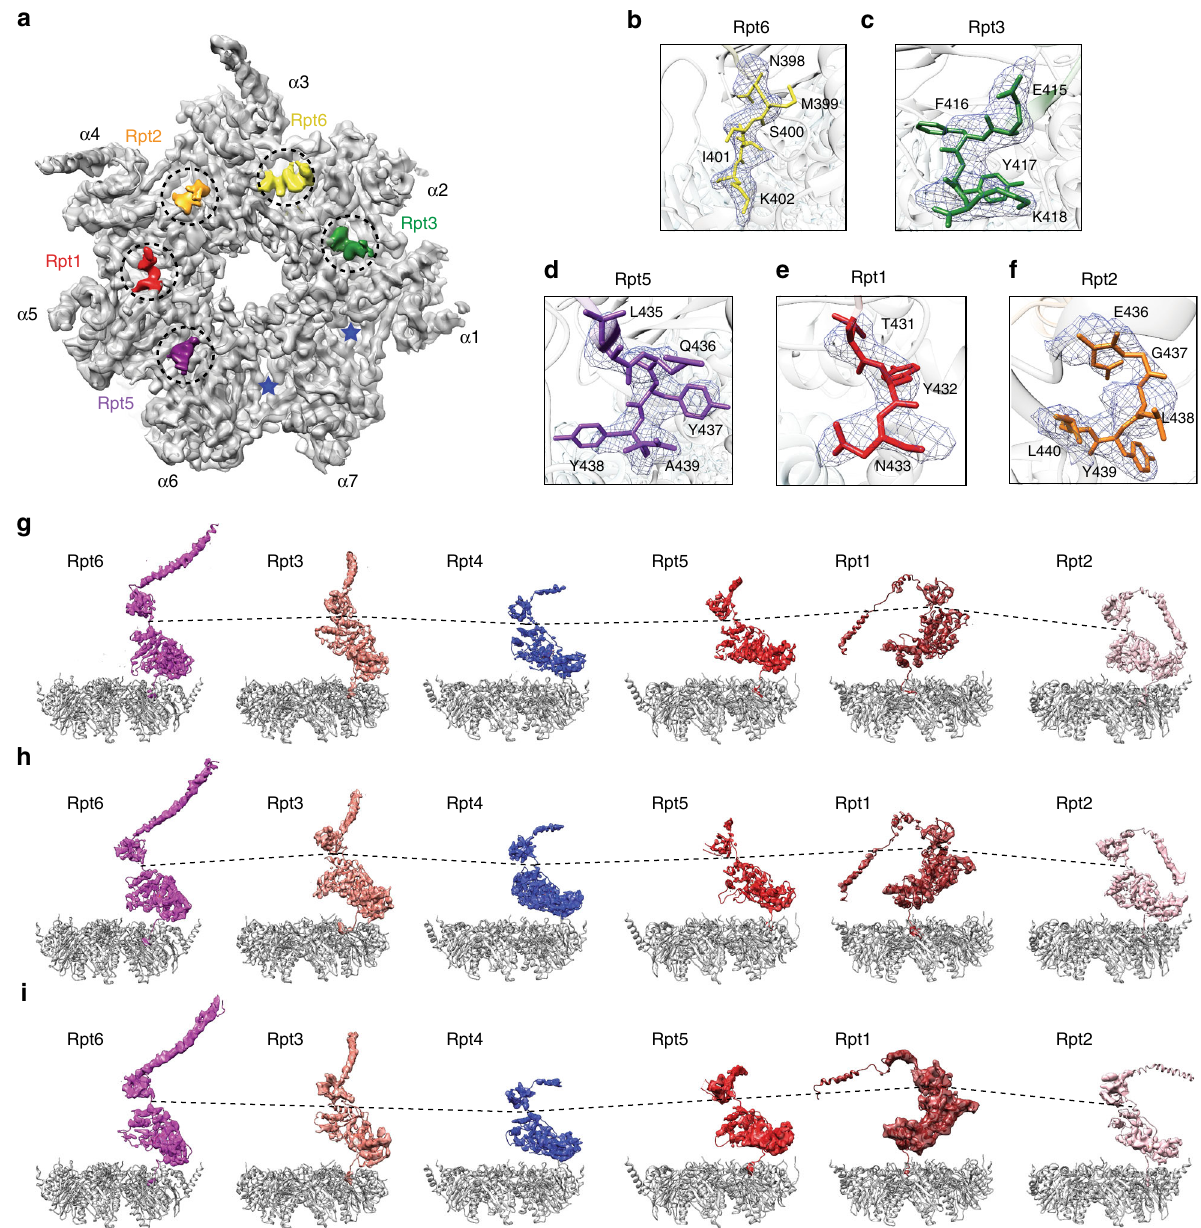
Fig. 4 RP – CP interactions regulate the gate opening. a Overview of the RP – CP interface in which the C-terminal tails of Rpt1, Rpt2, Rpt6, Rpt3, and Rpt5 are shown to insert into the corresponding α -pockets in the S D states. Two empty α -pockets are marked by asterisks. b – f Close-up views of each C-terminal tail shown in a stick representation superimposed over their corresponding cryo-EM densities shown in a mesh representation. g – i The Rpt subunits in cartoon representation superimposed with cryo-EM densities showing the vertical positions of each Rpt subunit relative to the α -ring in a gray cartoon representation in the S D1 ( g ), S D2 ( h ), and S D3 ( i )